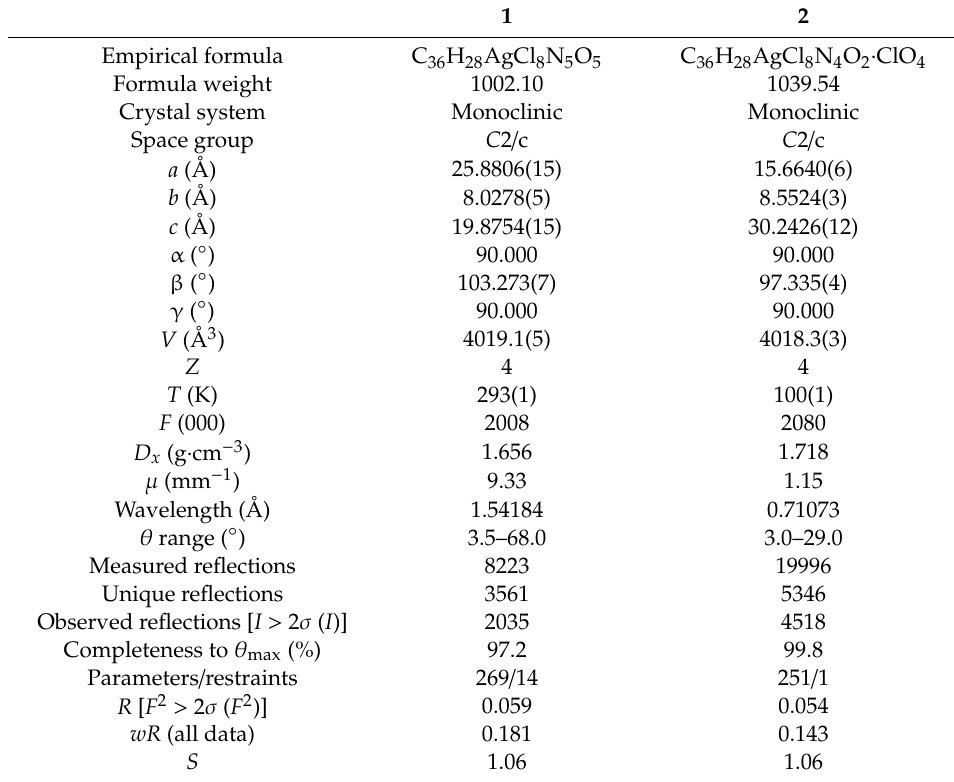
Table 2. Crystallographic data for 1 and 2 .